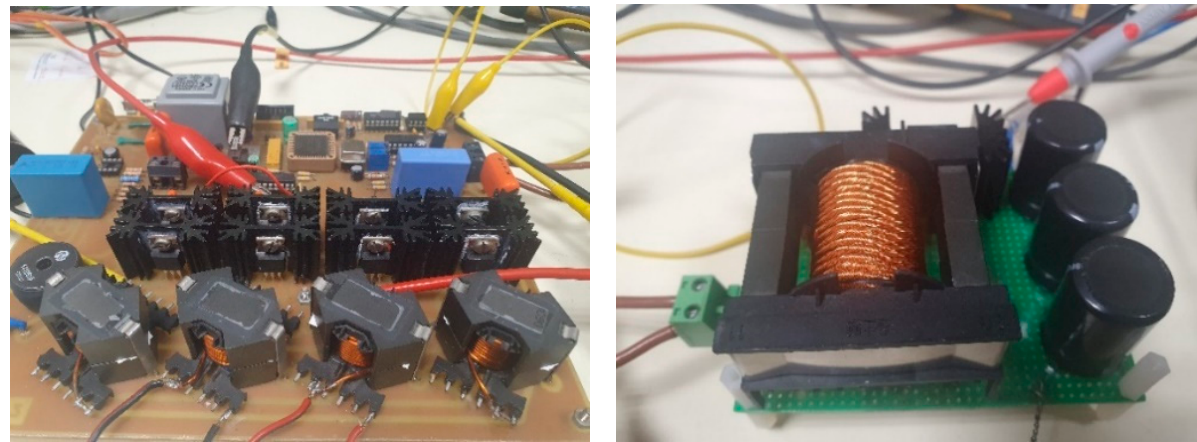
Figure 14. Details of the experimental prototype of the charger. ( Left ) Four-phase resonant inverter stage. ( Right ) Current- doubler rectifier.